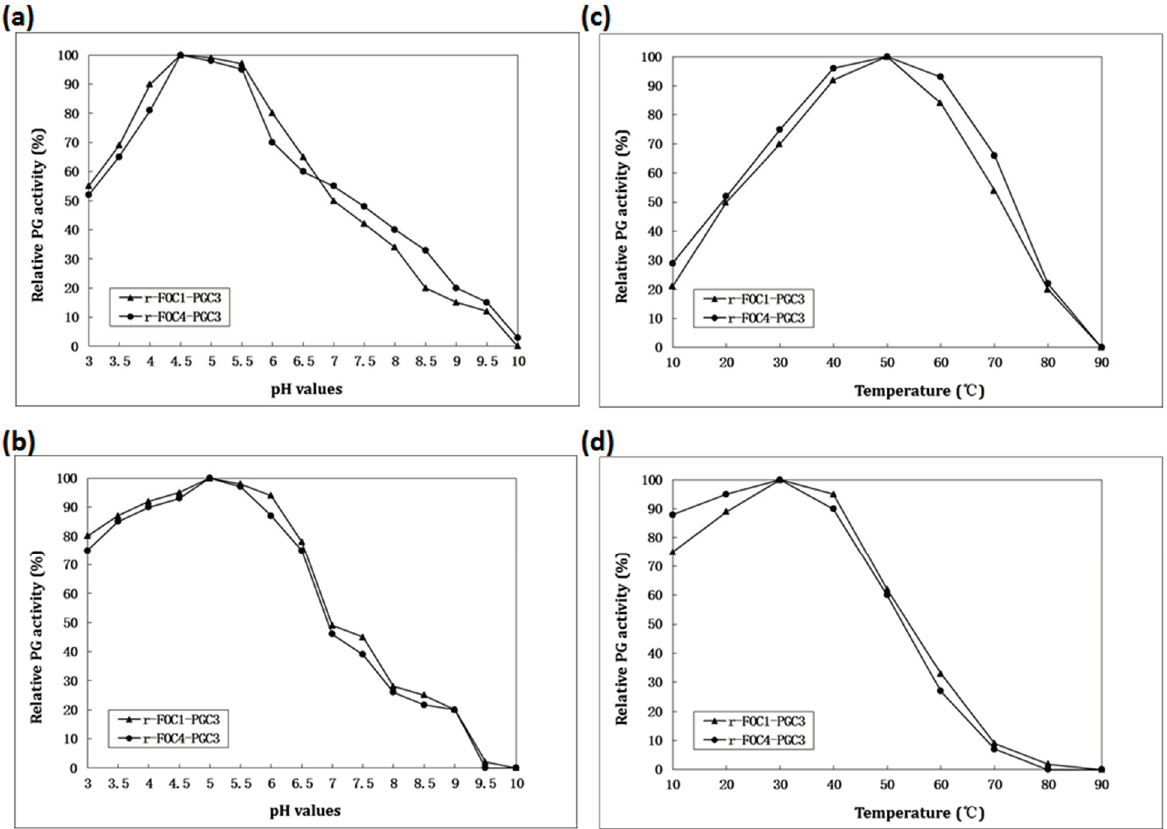
Figure 4. Enzymatic activity and stability. ( a ) Determination of the optimal pH; ( b ) Enzymatic stability with respect to pH; ( c ) Determination of the optimal